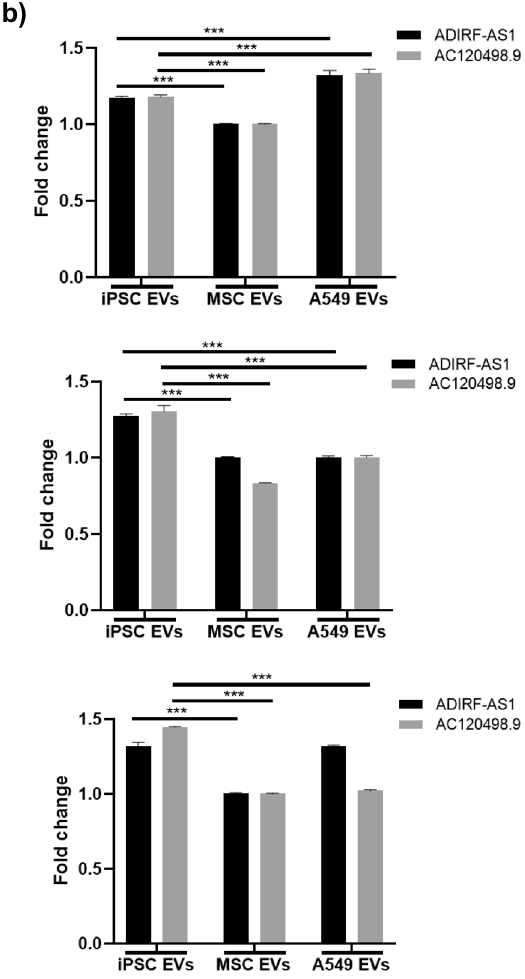
Figure 7. RNA pulldown assay. (a) The secondary structures of lncRNAs ADIRF-AS1 and AC120498.9 are shown. These lncRNAs contained continuous stretches of dsRNA ≥ 30 base pairs in length; for reference, the corresponding regions are enclosed in black boxes. (b) Total RNA was isolated from EVs and RT-qPCR was carried out using primers that were specific to the boxed sequences shown in panel a. Data were normalized to GAPDH and the relative expression levels were evaluated using the 2 −ΔΔCT method. n = 3. * p < 0.05, *** p < 0.0001. (c) Biotin-conjugated synthetic RNA sequences corresponding to the sequences of interest were incubated with SHSY5Ywhole cell extract. Western blot was performed to assess the expression of different RNA binding proteins (PKR, Dicer, ADAR1). (d) SHSY5Y cells were exposed to EVs from cART-treated, HIV-1 infected cells (U1) with or without treatment of stem cell EVs at an approximate ratio of 1:1000 (recipient cell to EV ratio). Stem cell EVs were exposed to UV(C) to inactivate EV-associated RNAs. Representative images show the appearance and morphology of cells after 8 days in culture. Inserts are included for higher resolution. Scale bar = 200 µm. n = 3. (e) Cell viability was quantified via CellTiter-Glo. n = 3. * p < 0.05 relative to U1 cART